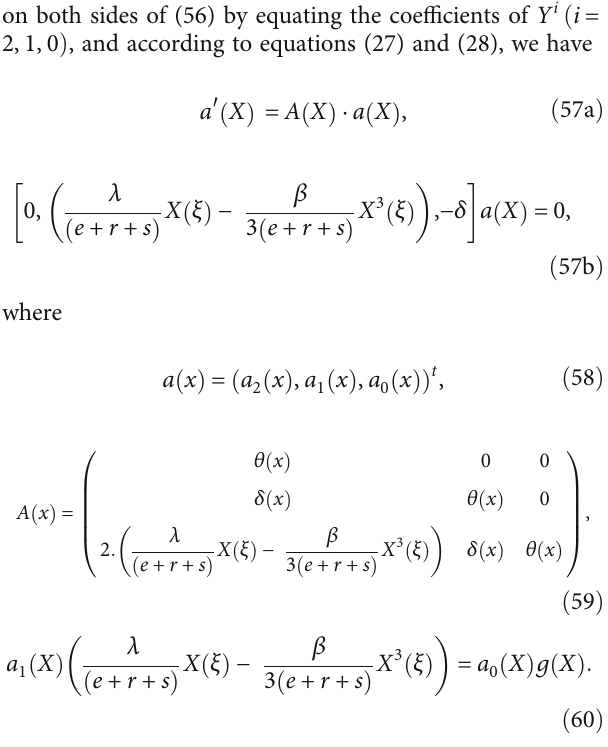
ffiffiffiffiffiffiffiffiffiffiffiffiffiffiffiffiffiffi p − e − r − s